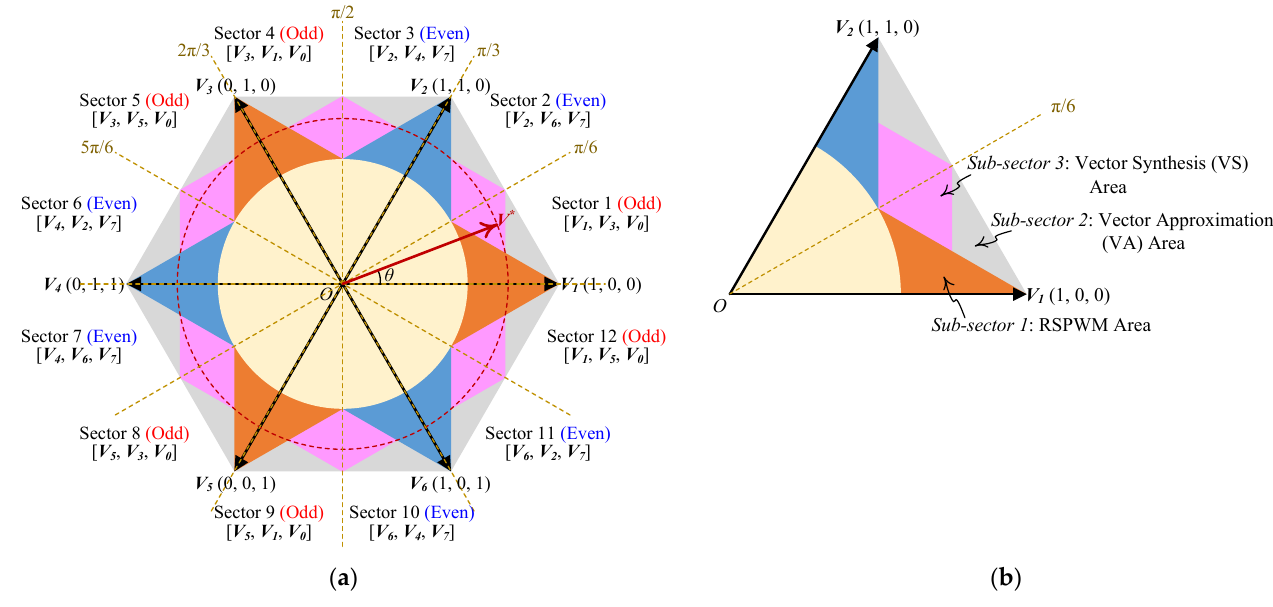
Figure 7. Voltage vector diagram of proposed method at MI > 0.604: ( a ) Overall diagram; ( b ) Sub- sectors in sector 1.